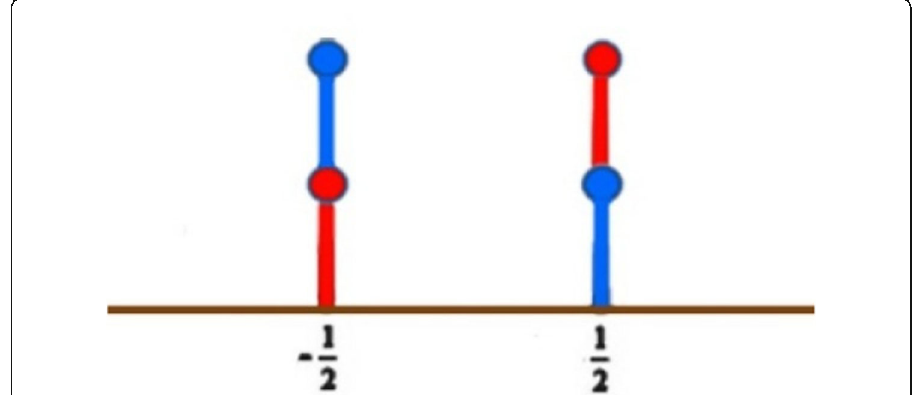
Fig. 11 Example of the inverse of 1